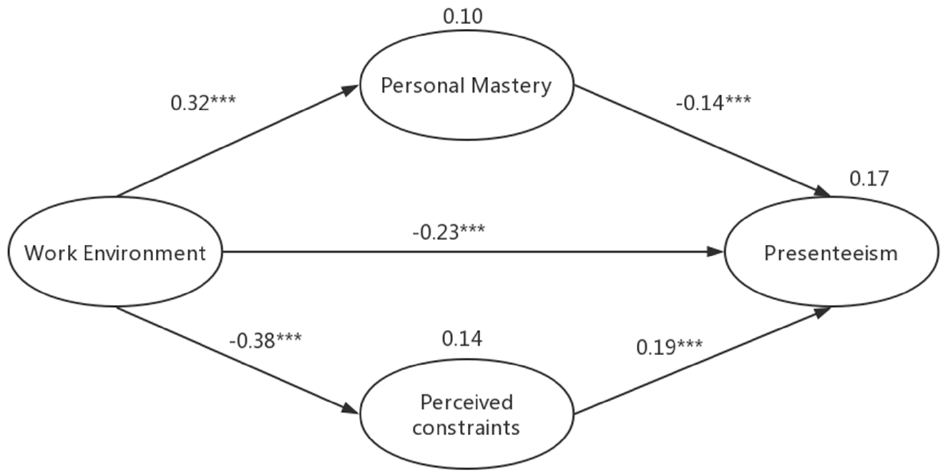
Figure 2. Mediator model of how work environment affects presenteeism (the numbers in the path are standardized regression coefficients and the numbers on the variables show variability, namely, root mean square error of approximation = 0.052, goodness-of-fit index = 0.955, comparative fit index = 0.961, Tucker–Lewis index = 0.954; *** p < 0.001).